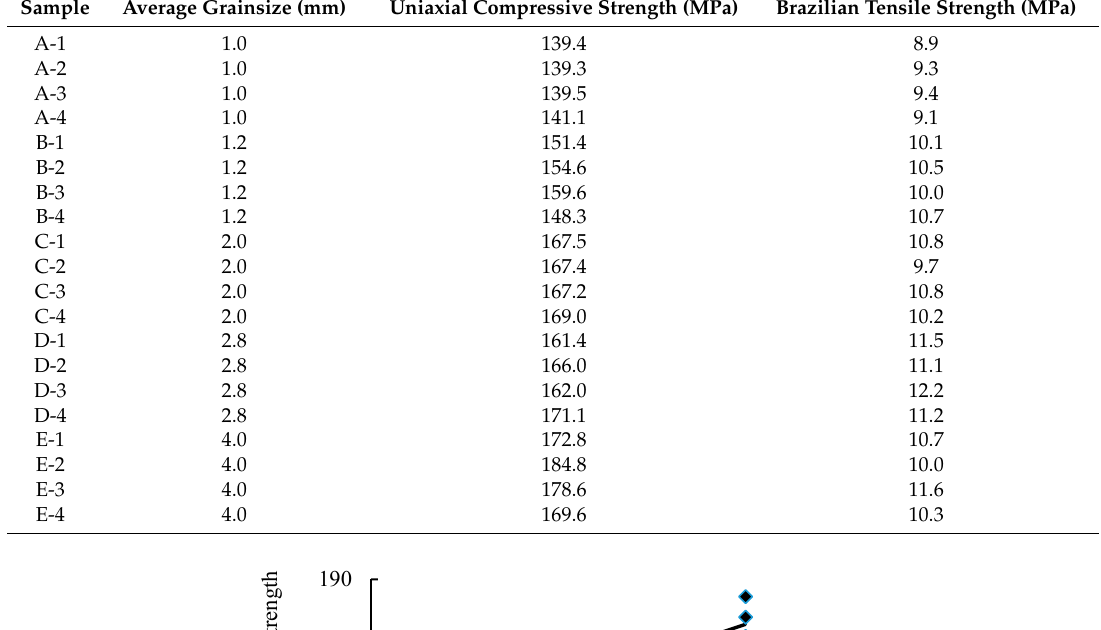
Table 2. The summary of uniaxial compressive strength and Brazilian indirect tensile strength.